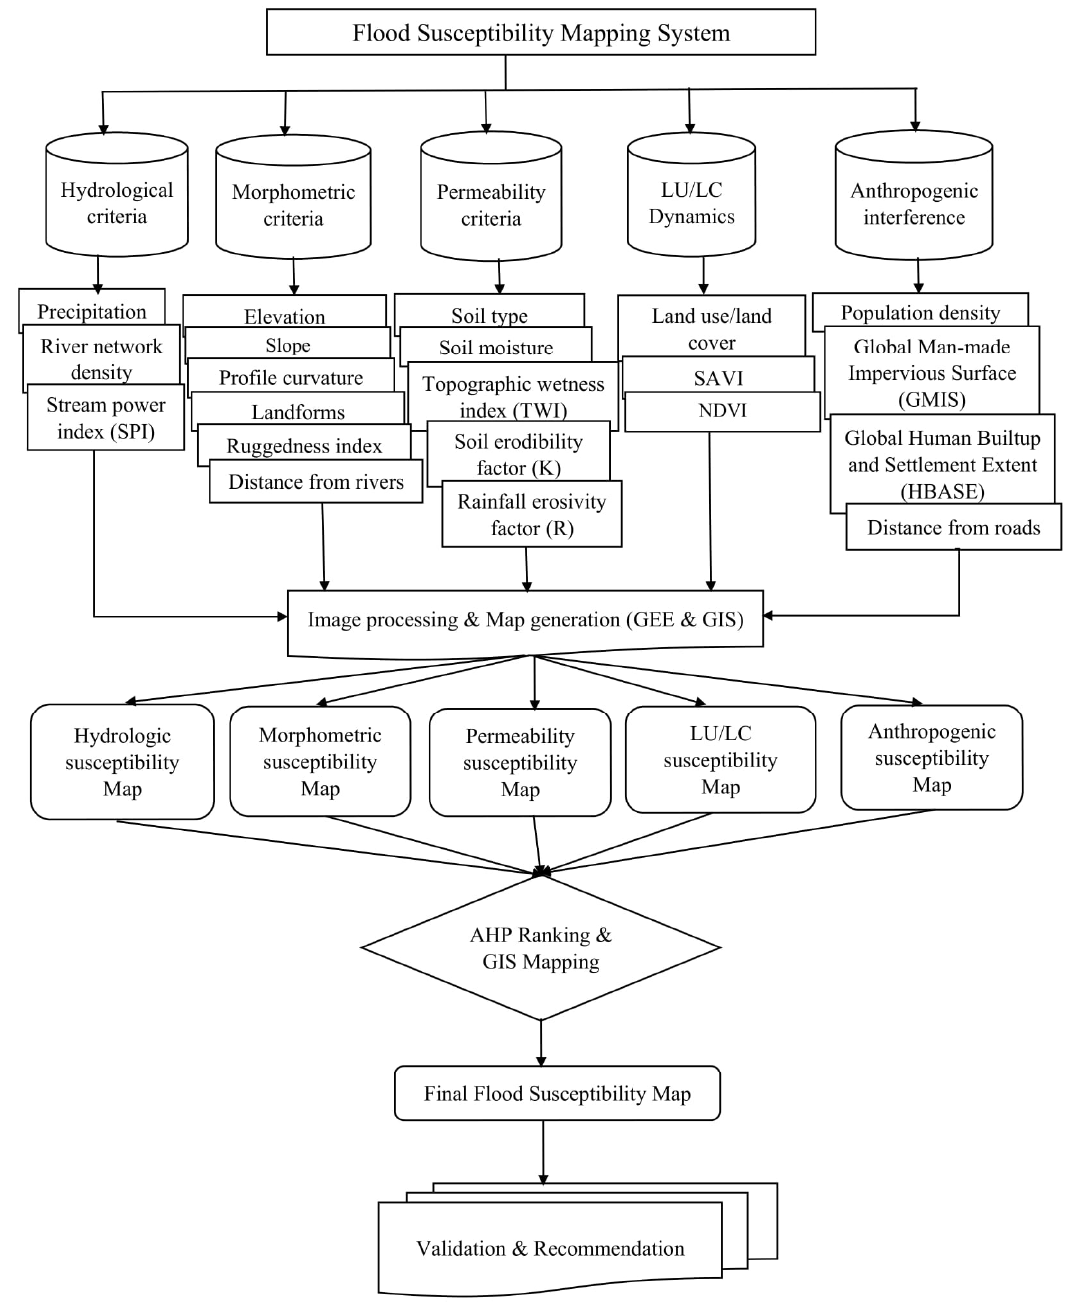
Figure 2. Schematic of the procedure used for flood susceptibility mapping in a region in Bihar,